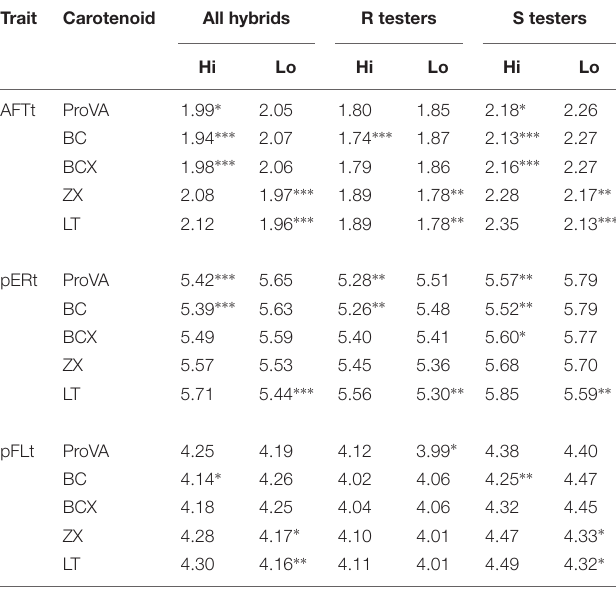
TABLE 5 | Contrasts of aflatoxin concentration (AFTt), ear rot (pERt), and fluorescence scores (pFLt) between hybrids with high (Hi) vs. low (Lo) grain concentrations of five carotenoids, analyzed for all 120 hybrids and independently for sub-sets of 60 hybrids of Aspergillus flavus resistant (R) or 60 hybrids of susceptible (S) tester lines.